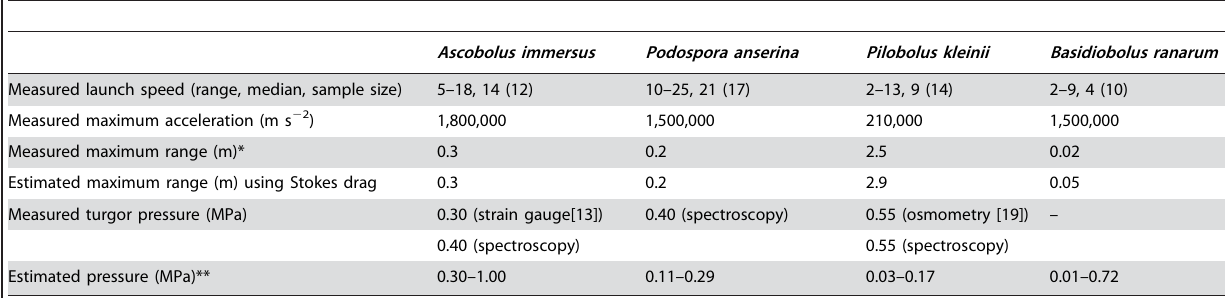
Table 1. Ballistics of spore and sporangium discharge in four coprophilous fungi based upon high speed video analyses and different models for the effects of viscous drag on particle